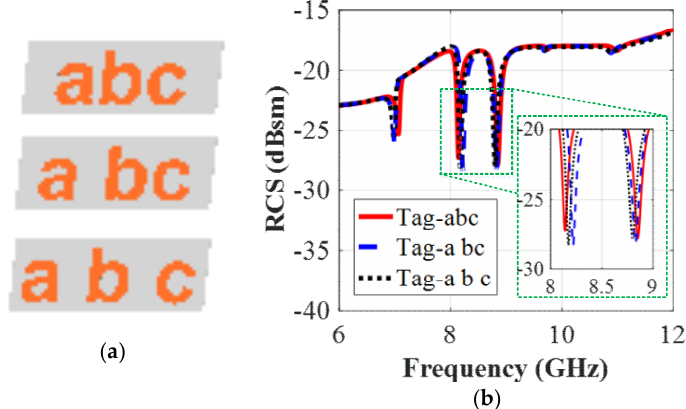
Figure 16. RCS simulation results of the tag-abc with and without space between the letters: ( a )